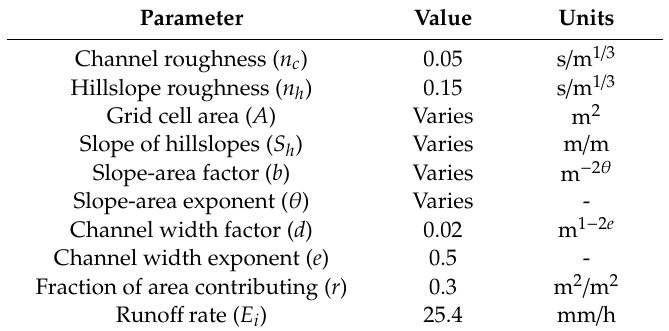
Table 4. Model parameters used in the development of the instantaneous unit hydrographs. Parameters that vary are determined from the digital elevation model for each